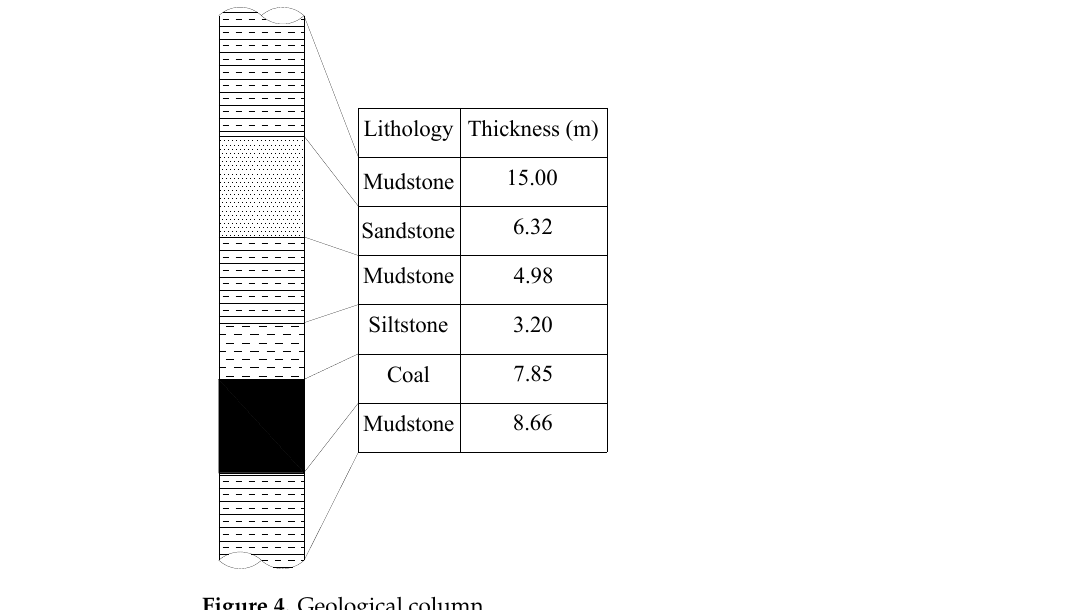
Figure 4. Geological column.